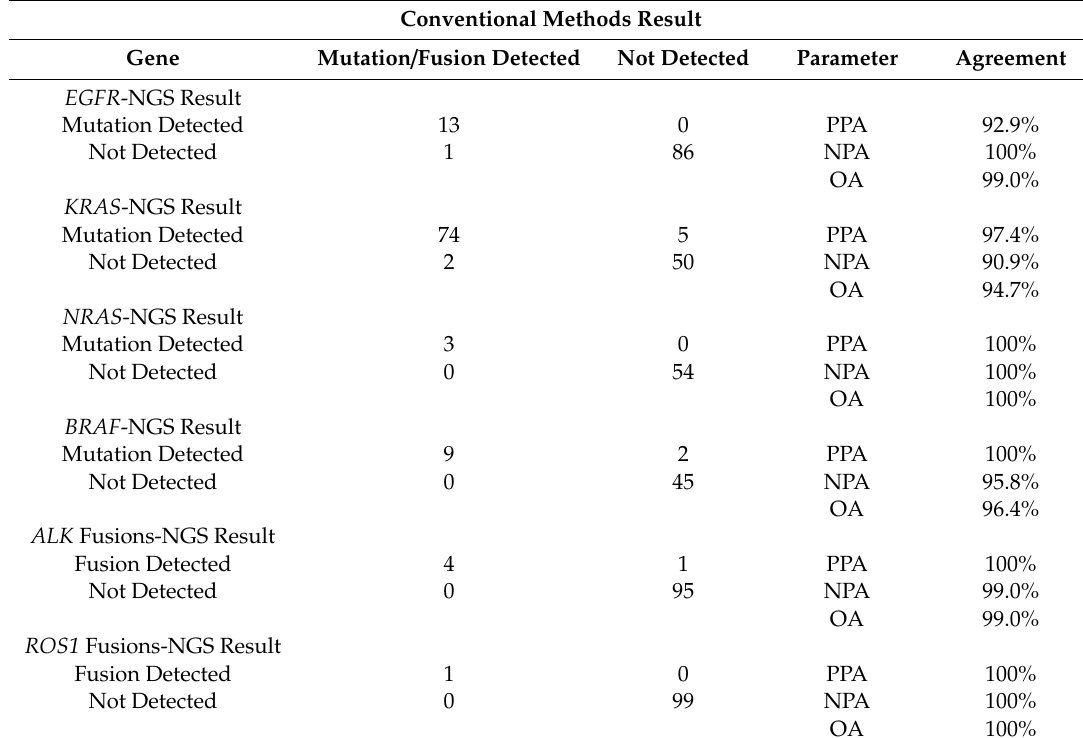
Table 1. Comparison of NGS results with conventional